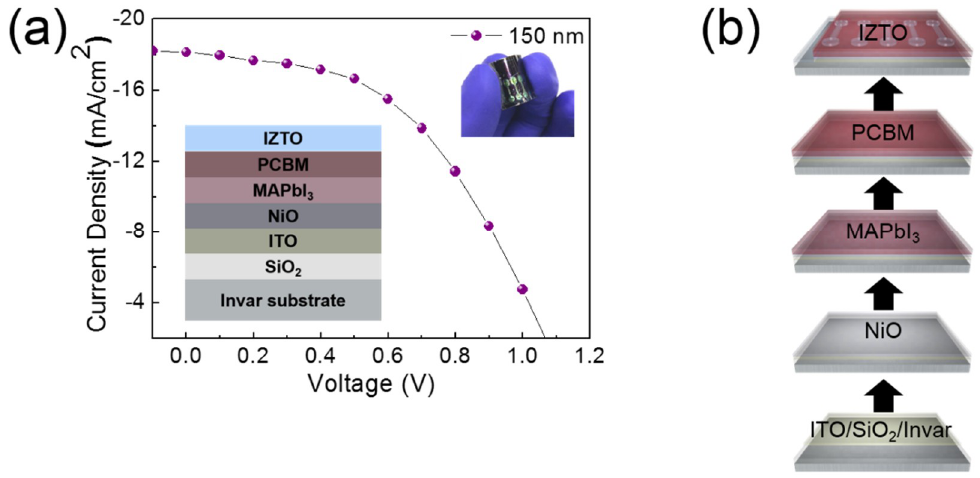
Figure 6. ( a ) Current density-voltage ( J - V ) curve of PSC fabrication on the ITO (150 nm)/SiO 2 /invar substrate (under AM 1.5 solar light). ( b ) Schematic of a PSC fabrication procedure on the ITO (150 nm)/SiO 2 /invar substrate. Table 3. Key parameters of PSC based on ITO (150 nm)/SiO 2 /invar substrate. ITO thickness